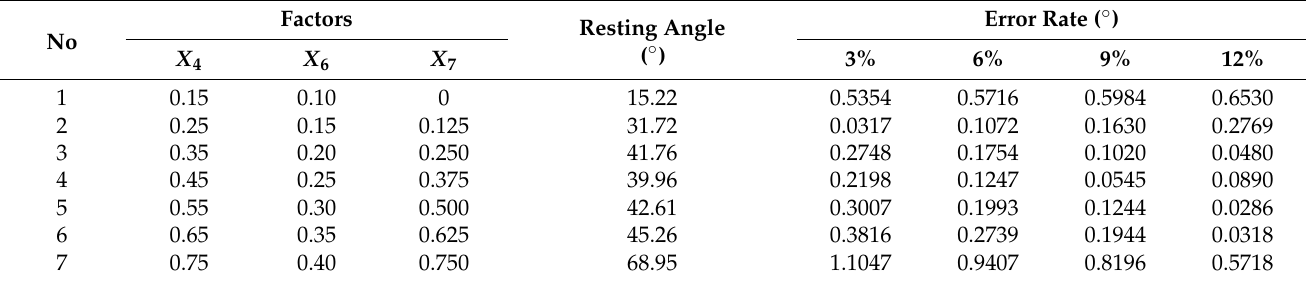
Table 8. Steepest climbing test arrangement and